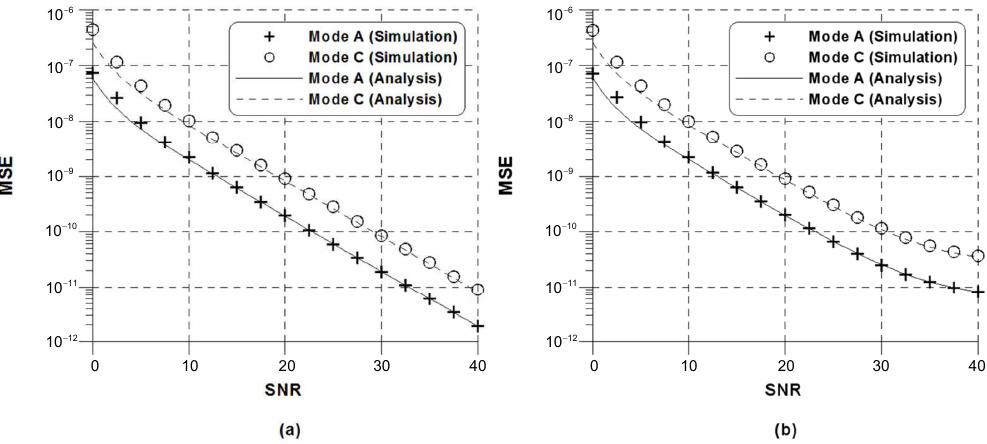
Figure 2. MSE of the proposed frequency estimator in CM1: ( a ) ∆ f = 10 − 2 ; ( b ) ∆ f = 3 × 10 − 2